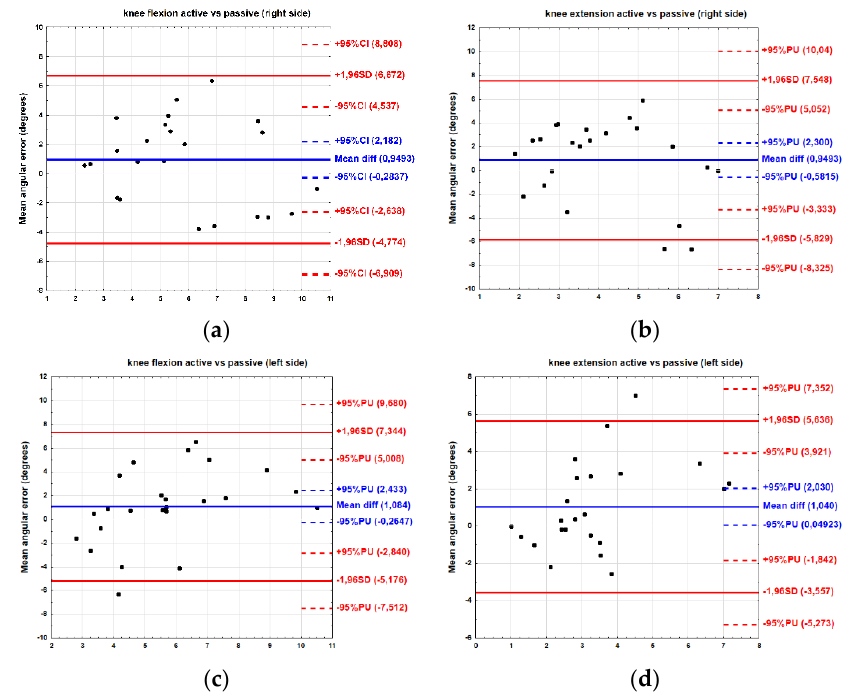
Figure 5. Bland–Altman plot showing agreement between active and passive modes for right ( a , b ) and left ( c , d ) sides of joint position sense